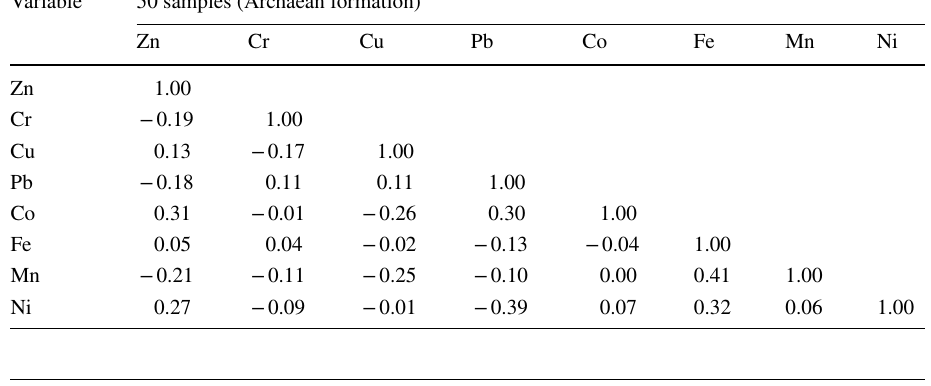
Table 3 Correlation analysis of quaternary